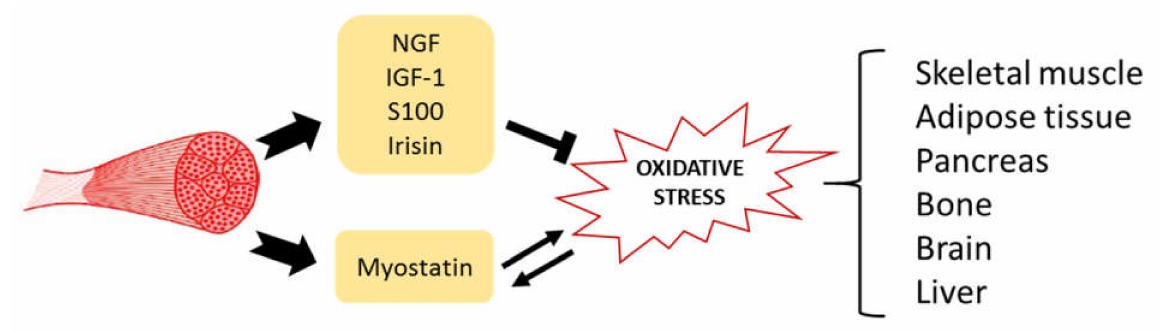
Figure 2. The role of myokines. Myokines are product of the muscle secretome; their action is widespread throughout the body. Most myokines are able to act specifically against oxidative stress, improving mitochondrial function and reducing ROS production, while myostatin increases oxidative stress that in turn increases myostatin